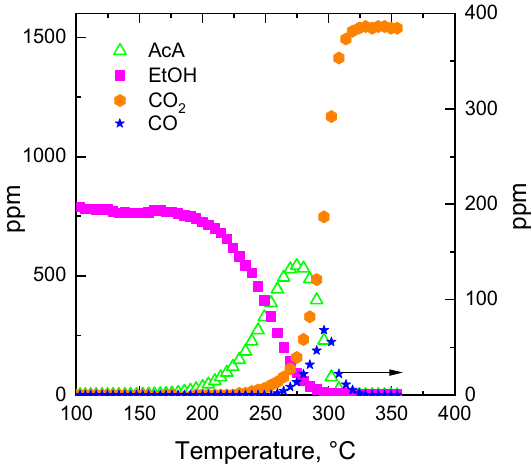
Figure 7. Concentrations of ethanol, acetaldehyde (AcA), CO, and CO 2 in dependence on reaction temperature obtained during ethanol oxidation over the Co-RF-ox / ap